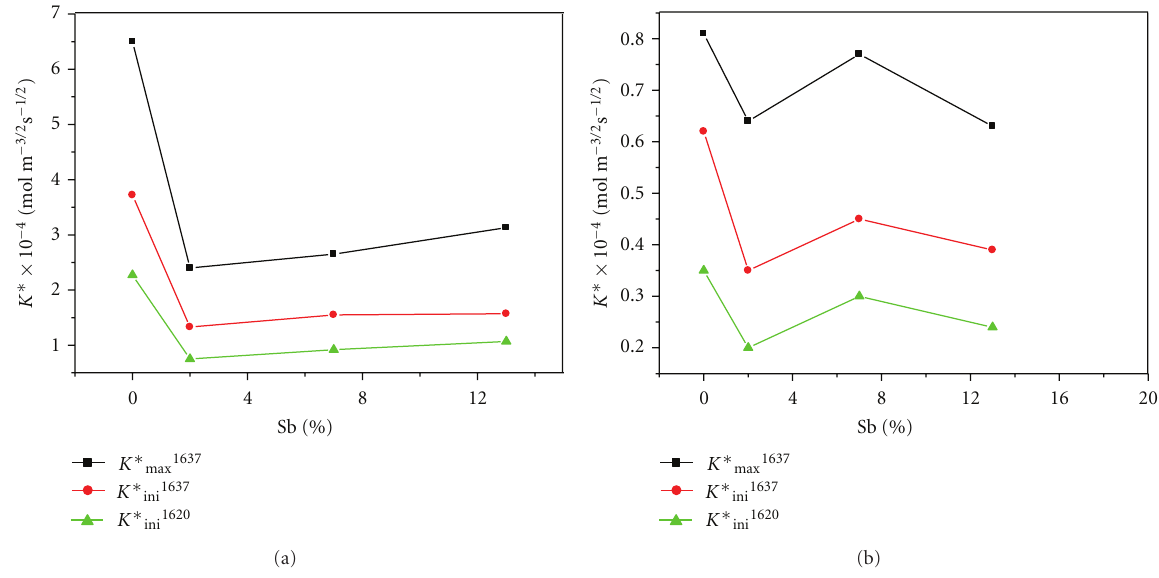
Figure 7: The influence of the Sb-doping level on K ∗ max1637 , K ∗ max1637 , and K ∗ ini1620 calculated from the data given in Figure 6. When Sb = 0% the K ∗ max1637 values shown are actually the K ∗ max1637 (corr.) values. (a) λ = 315 nm; (b) λ = 365 nm.